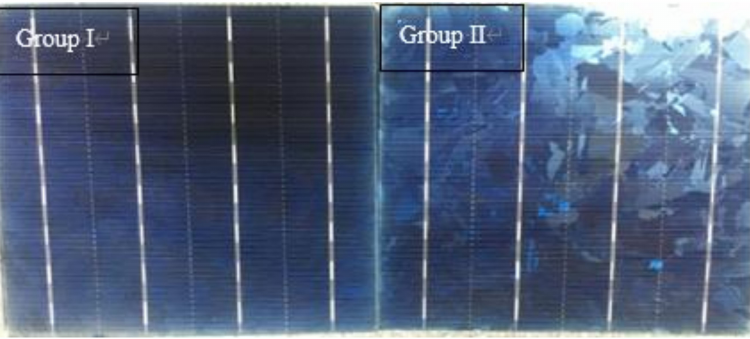
Figure 5. The appearance comparison diagram of black silicon wafers after pre-cleaning.